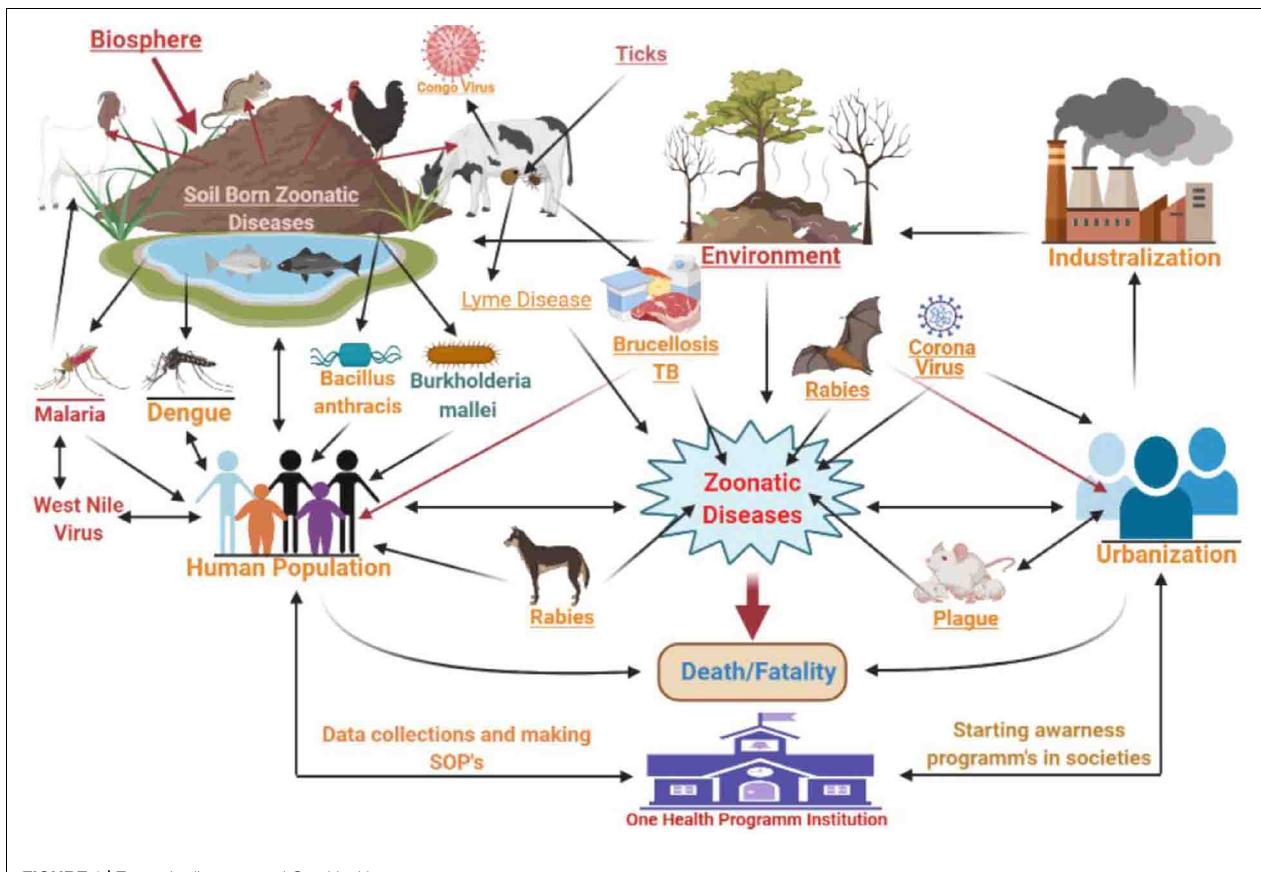
FIGURE 1 | Zoonotic diseases and One Health